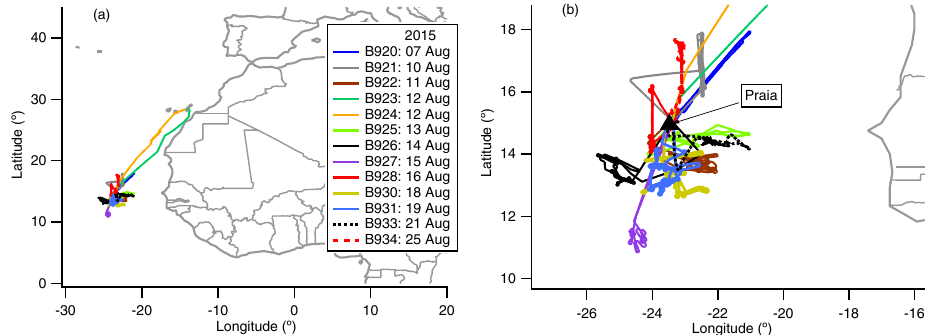
Figure 1. (a) A summary of all flight tracks. (b) Zoomed-in view of flights’ tracks; the solid triangle denotes the location of the ground measurement